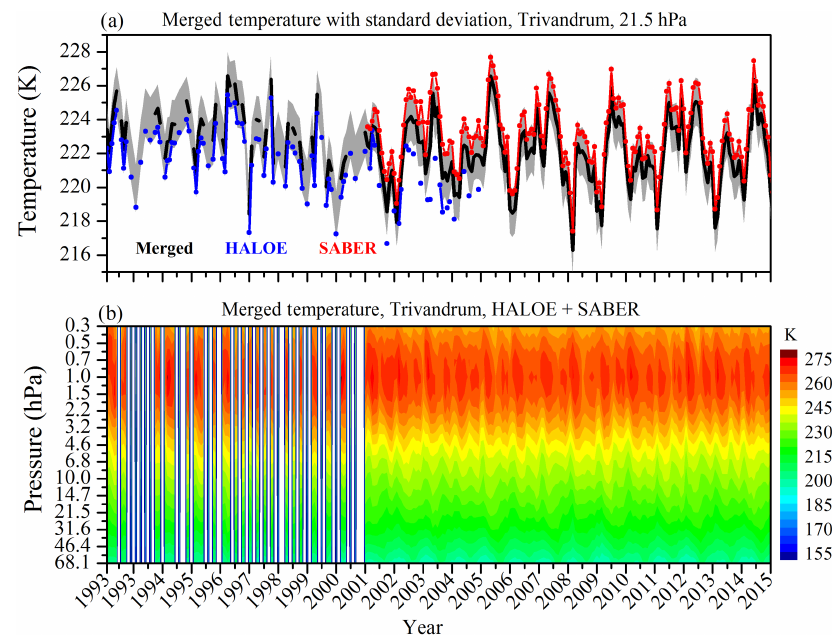
Figure 3. (a) Systematic error calculated from monthly mean temperature observations from HALOE and SABER over Trivandrum at 21.5hPa with source data. (b) Contour of the temperature over Trivandrum from 1993 to 2015 after removing the